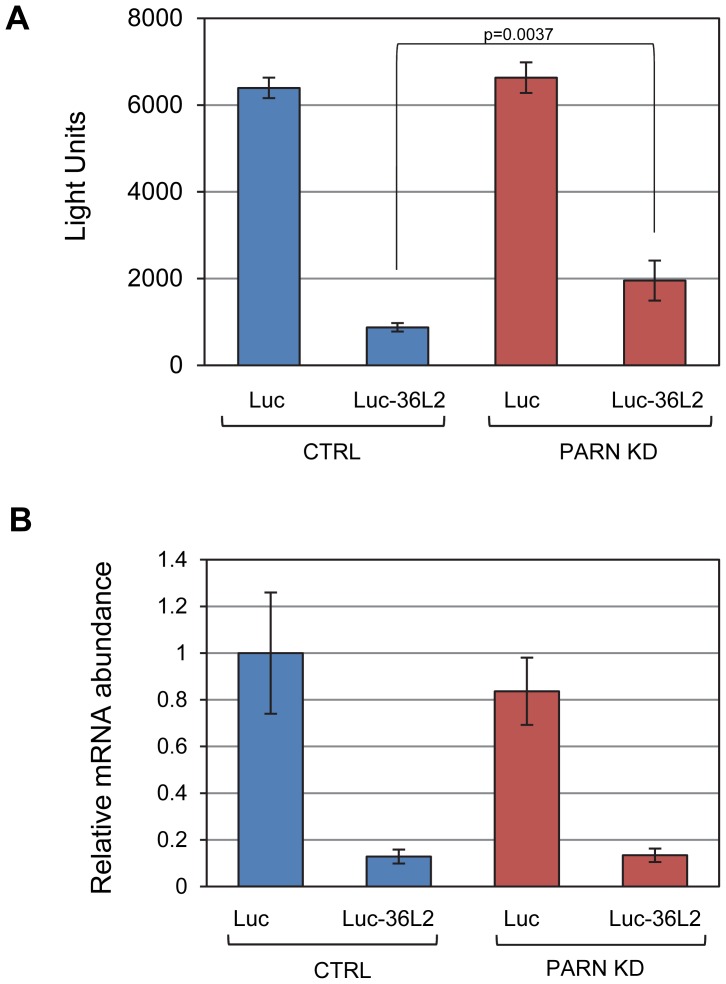
PARN acts through the 3′UTR of Zfp36l2 to repress translation.(A) Luciferase assays were performed in CTRL and PARN KD cells following transfection with empty pLightSwitch_3′UTR vector (Luc) or pLuc-36L2 which bears the Zfp36l2 3′UTR. Error bars are pooled standard deviations derived from three independent experiments. The asterisk indicates a statistically significant difference (p<0.002). (B) Abundance of Luc and Luc-36L2 mRNAs was determined by qRT-PCR and normalized to the abundance of Gapdh mRNA. Error bars represent pooled standard deviations derived from three independent experiments.